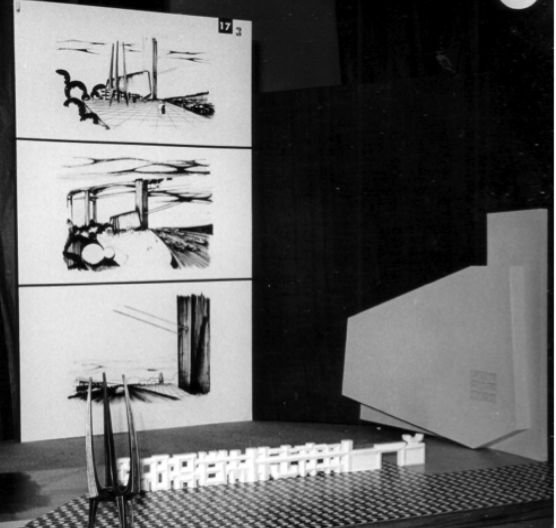
FIGURE 11 | C. Silva, J. Vieira, Mooring of the bridge over the Tagus, 1966, project.